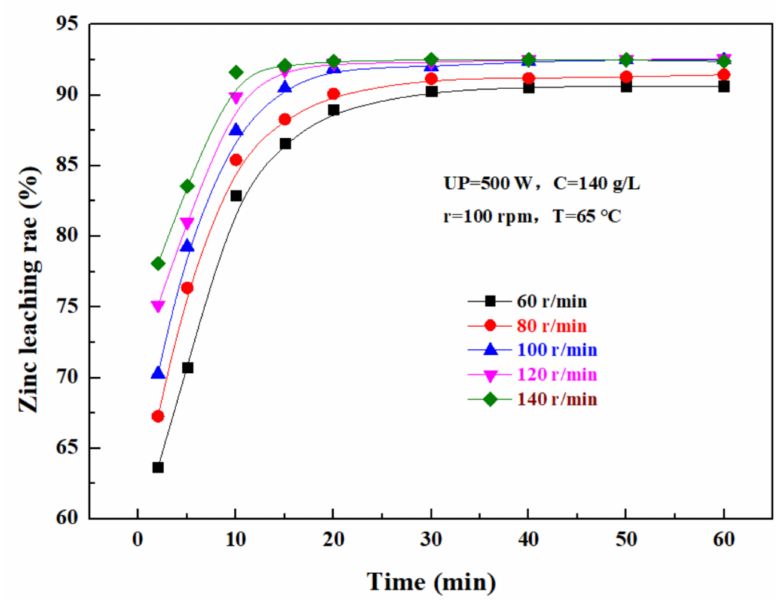
Figure 9. Effect of rotating speed on zinc leaching